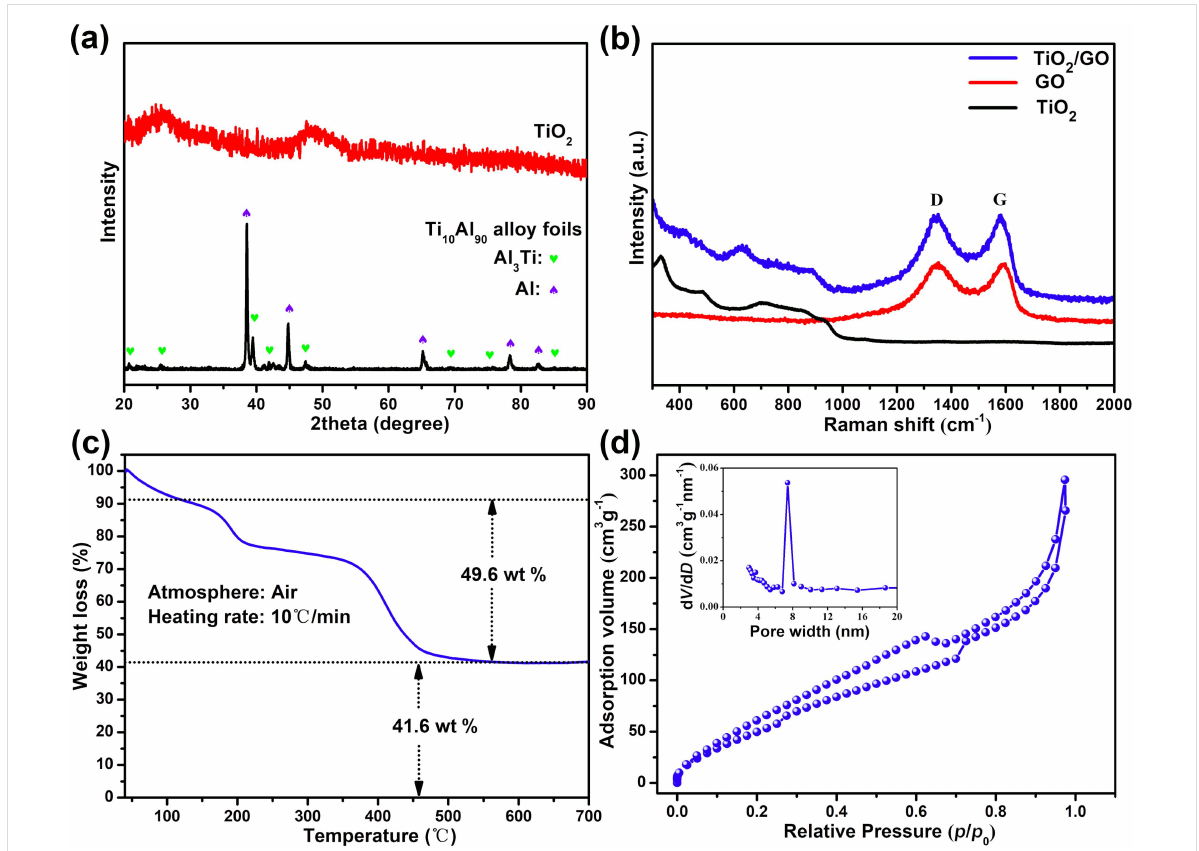
Figure 2: (a) XRD patterns of the as-spun and as-dealloyed Ti 10 Al 90 alloy foils. (b) Raman spectra of TiO 2 , GO and the TiO 2 /GO composite. (c) TGA curve and (d) N 2 adsorption–desorption isotherms and pore size distribution of the TiO 2 /GO composite.